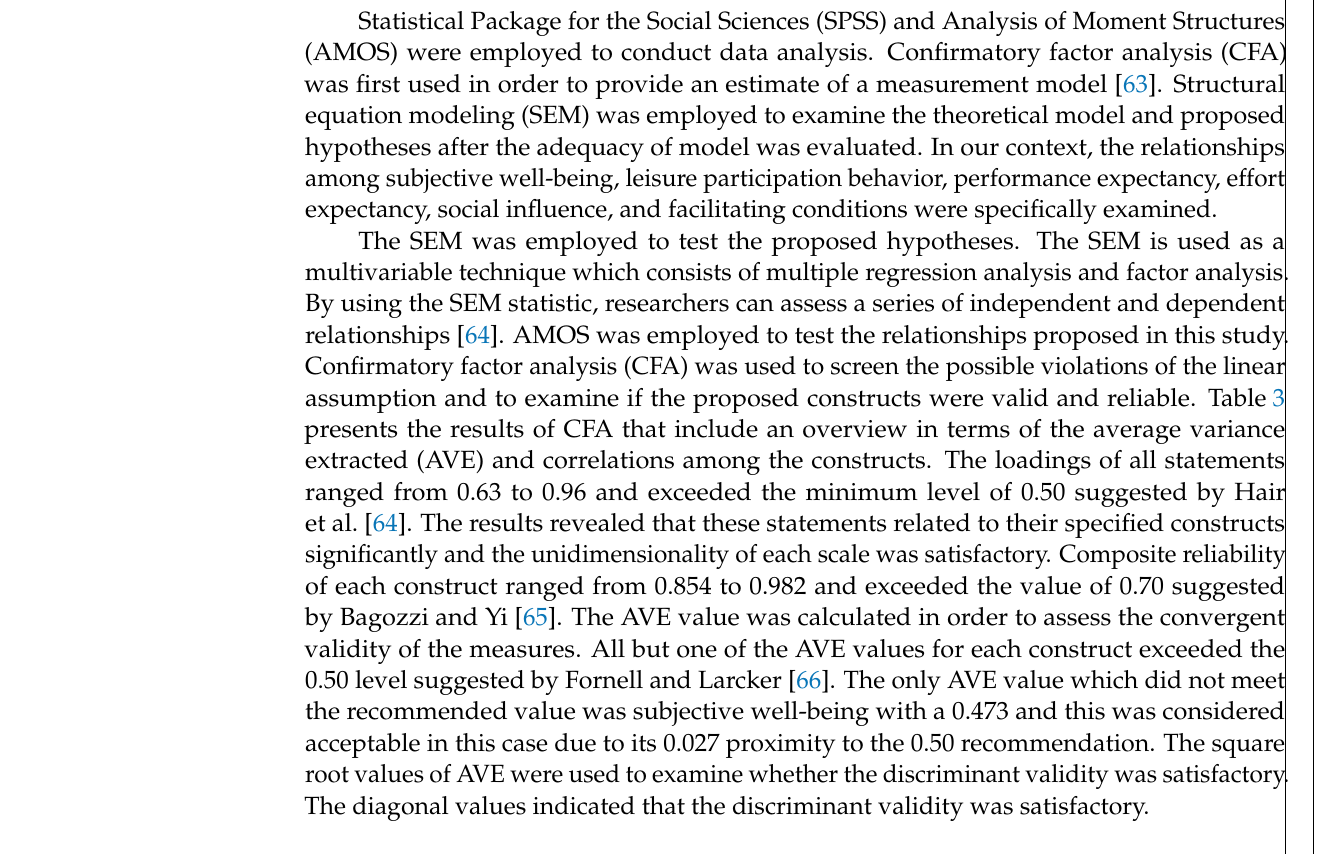
Table 3. Measures of correlations, AVE, and composite